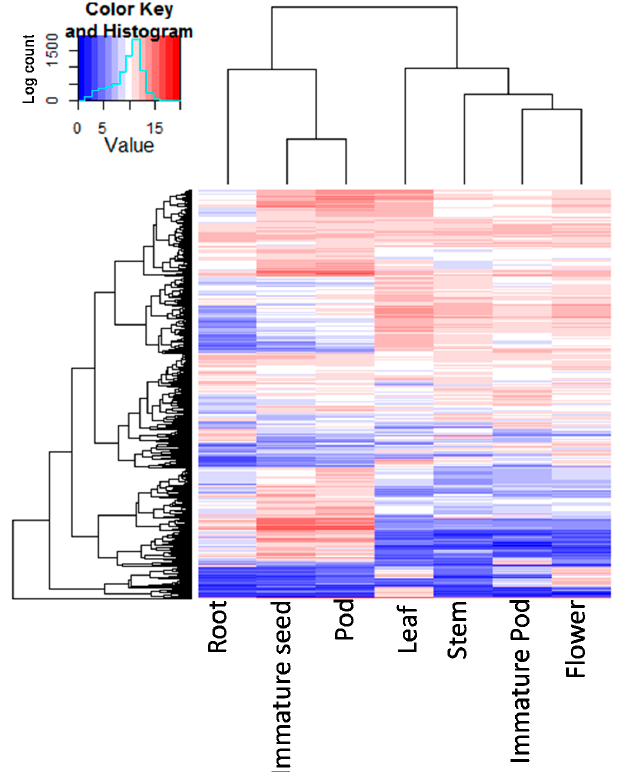
Figure 4. A heat map of the 1000 most differently expressed transcripts showing the hierarchical clustering of different tissues: The colour key represents the normalised log transformed counts. Red indicates high expression, white indicates intermediate expression and blue indicates low expression.